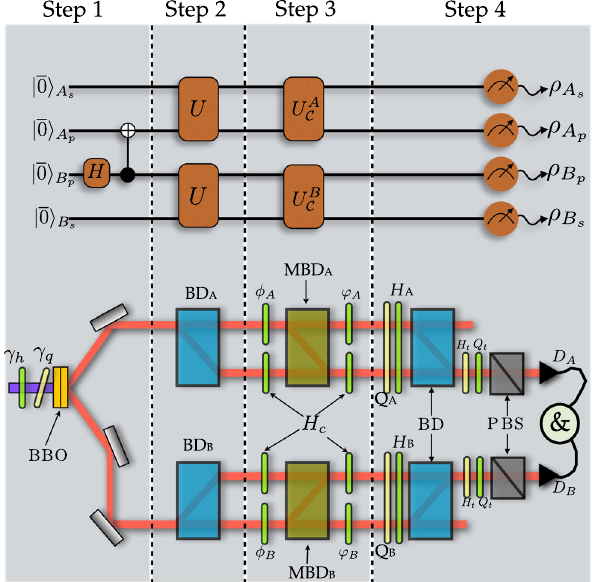
FIG. 5. Experimental setup for the case of four qubits. The top panel shows the quantum circuit describing our experiment. In the main text, we give a complete description of each step in this circuit as well as of its implementation in the optical scenario, showed in the bottom panel of the figure. The parameters α and β appearing in Eq. (B1) can be controlled by the half-wave ( γ ) and h quarter-wave ( γ ) plates located before the BBO crystals. The q MBD, in contrast with the common BD, transmits the horizontal polarization and deflects the vertical one. Physically, it is implemented by putting a BD between two half-wave plates, which are not shown in the figure. The θ plates are used to ensure identical path lengths in the interferometers. H and Q are half- i i and quarter-wave plates used in the tomographic process, as explained in the text, and the symbol & represents coincidence